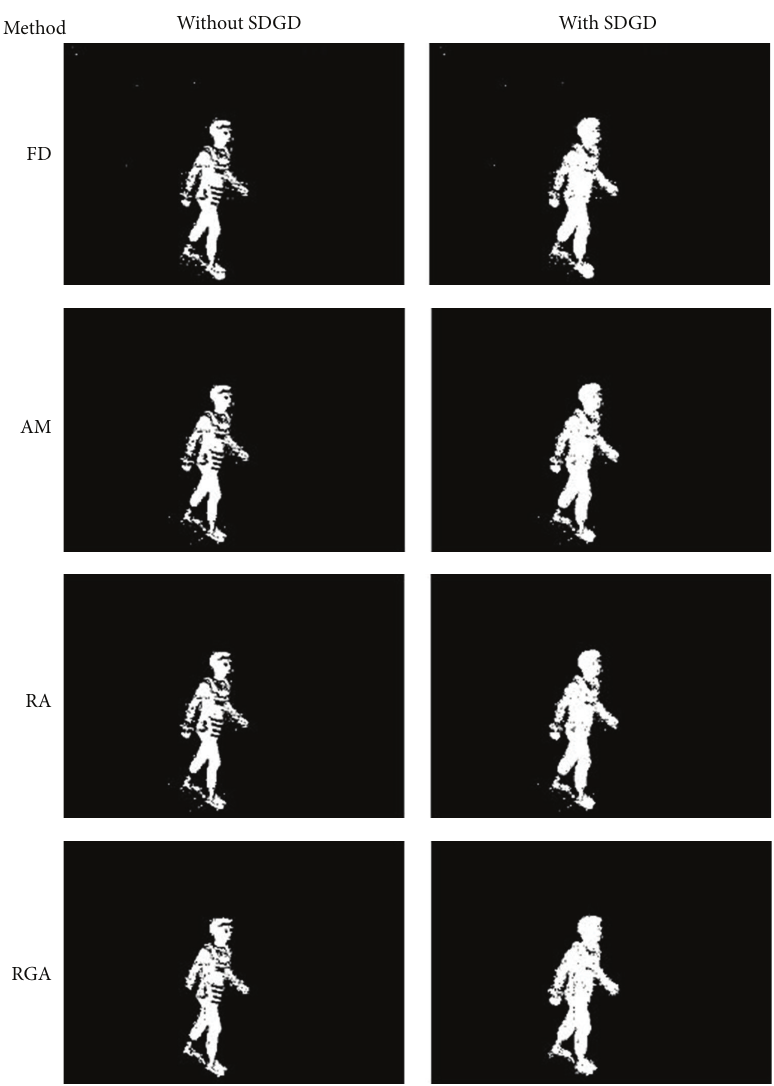
Figure 6: Segmentation performance using various background subtraction techniques for an indoor